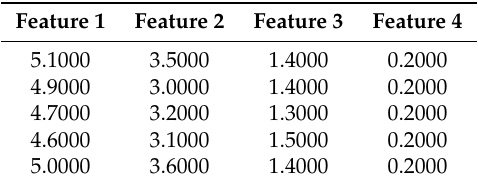
Table 5. Five samples from the first class (A).